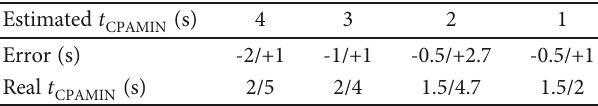
Table 4: t estimation results. CPAMIN